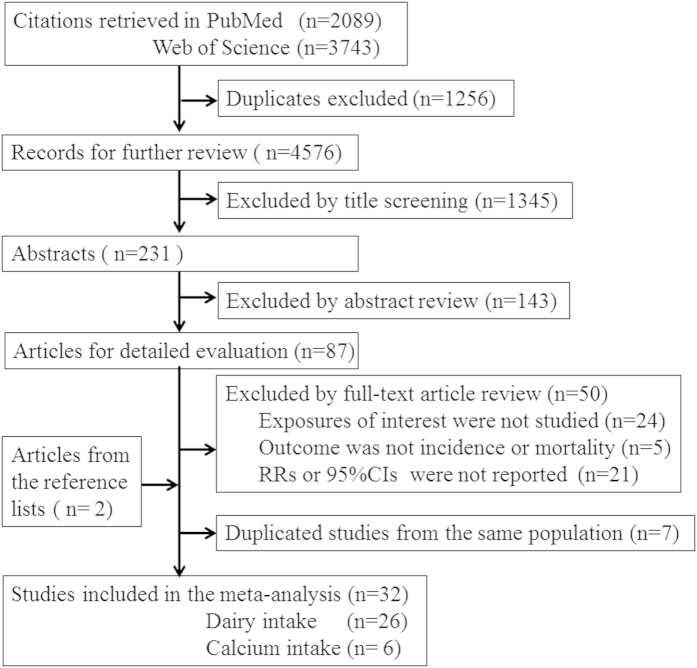
Flow chart of literature search in the meta-analysis.